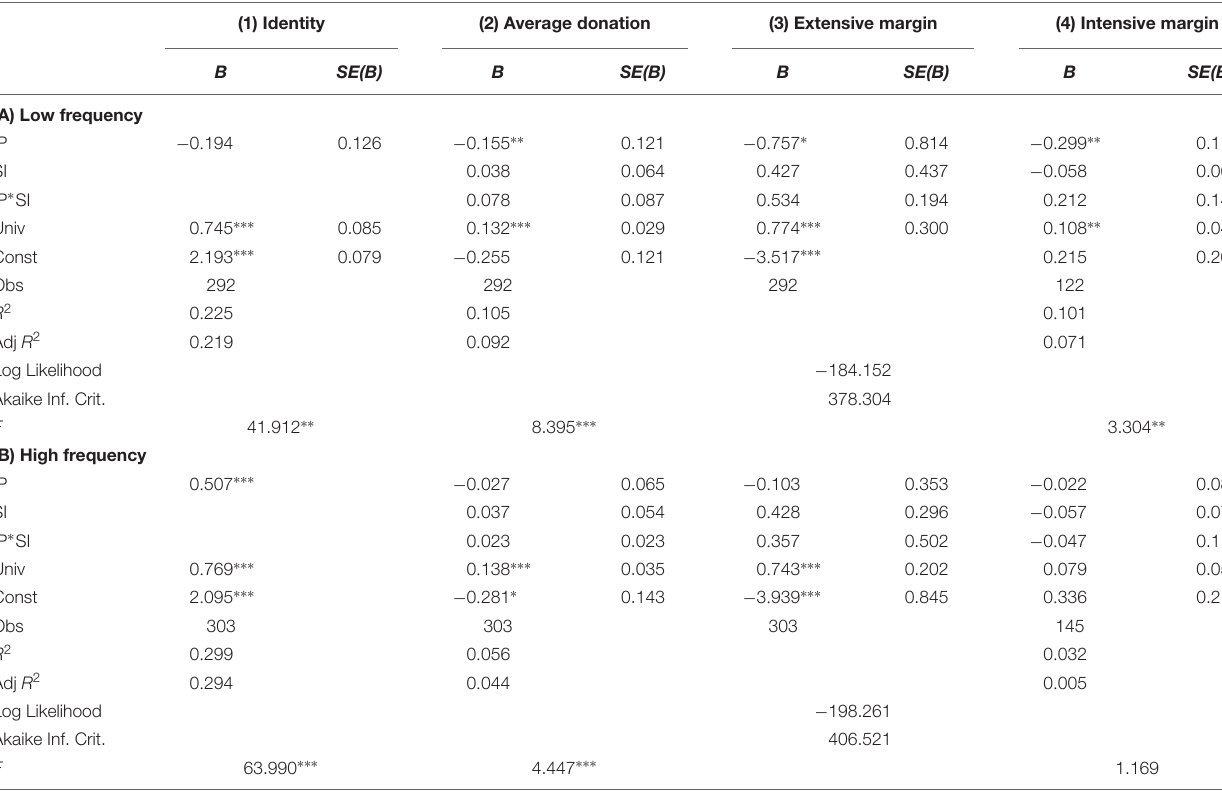
TABLE 3 | Effect of identity priming and social information for Low frequency (A) and High frequency (B) groups in Study